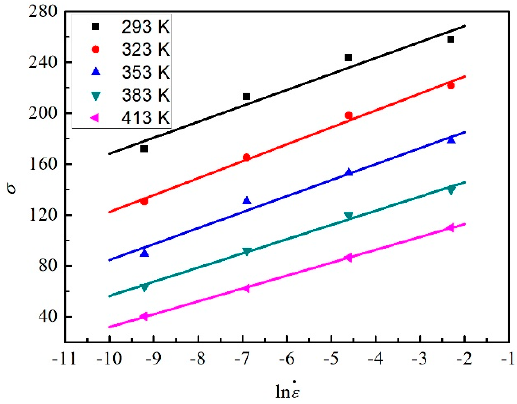
Figure 13. The relation between σ and ln ε for five temperatures at the strain of 0.3.